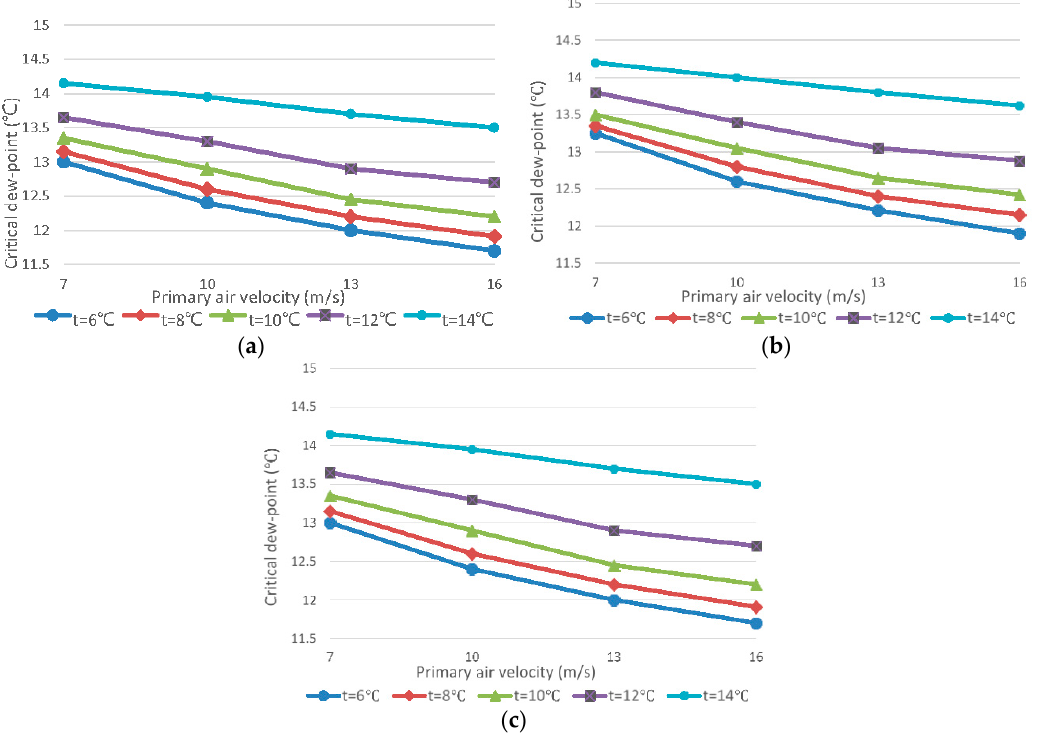
Figure 4. The primary air velocity and the critical dew-point temperature: ( a ) H = 3%; ( b ) H = 6%; and ( c ) H = 9%.